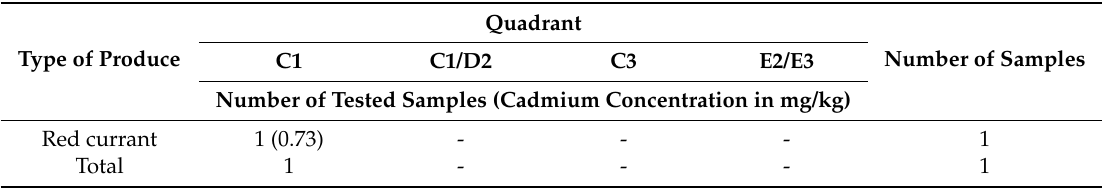
Table 5. Type of produce and number of samples in which cadmium concentration exceeded threshold value village Baroševac during 2015.